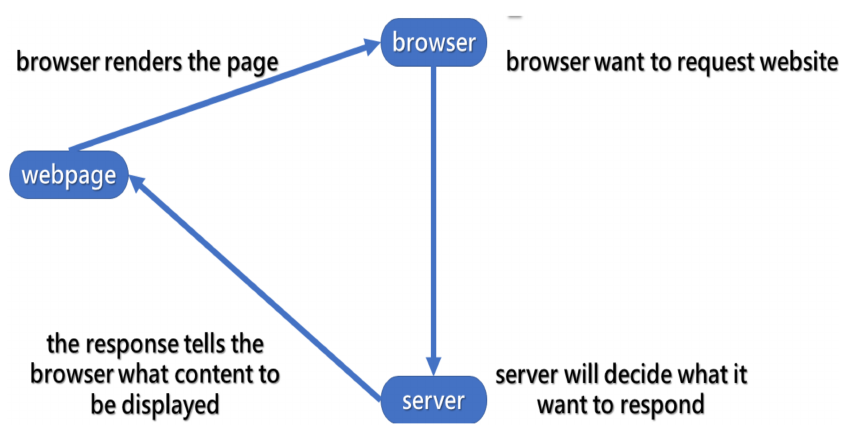
Figure 5. Step chart of http